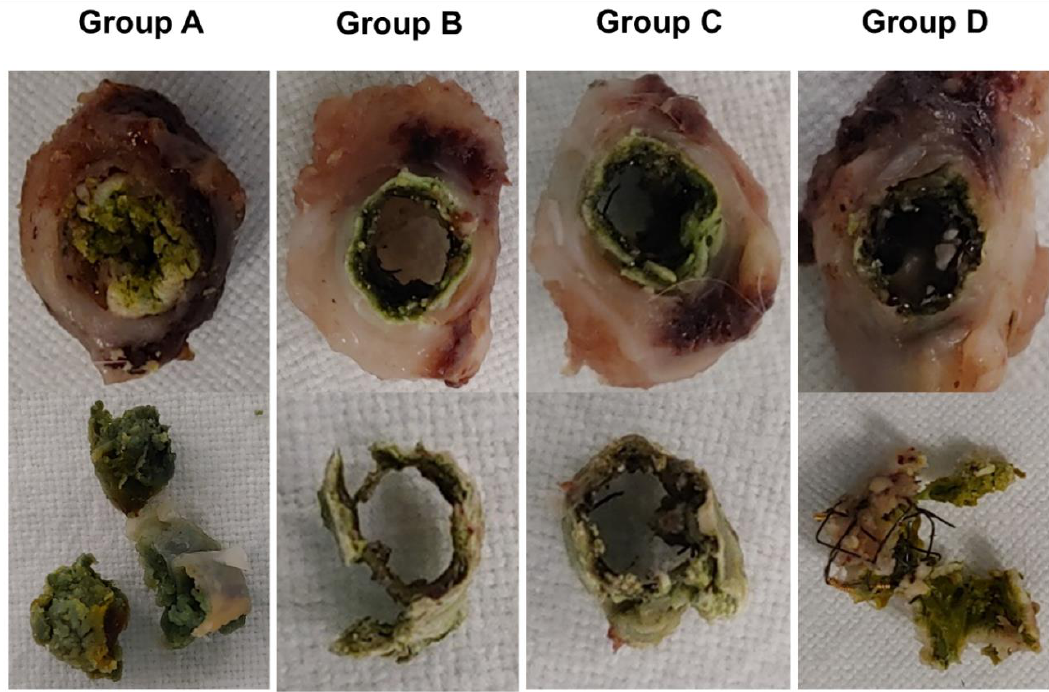
Figure 3. Biliary sludge formation in group A considerably increased compared with groups B, C, and D. However, biofilm formation adjacent to the SEMSs was observed in all groups.